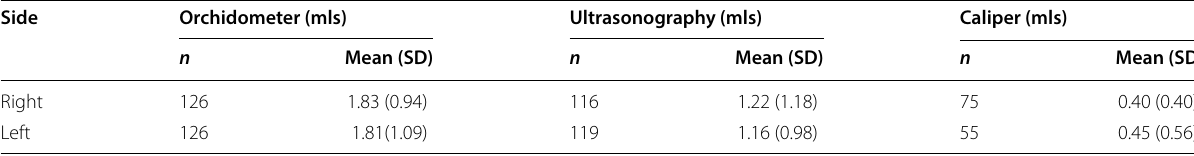
Table 1 Testicular volume measurements by side and